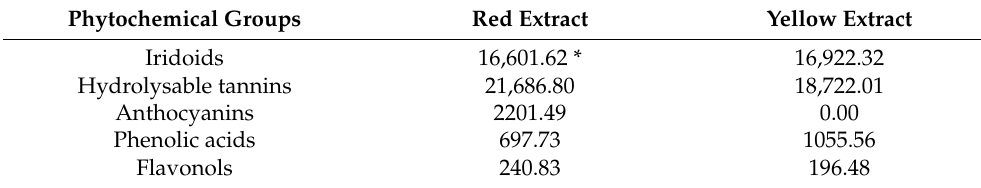
Table 1. Characteristic (mg/100 g dry weight (dw)) of purified extracts from red (red extract) and yellow (yellow extract) cultivars of CM fruits. Phytochemical Groups Red Extract